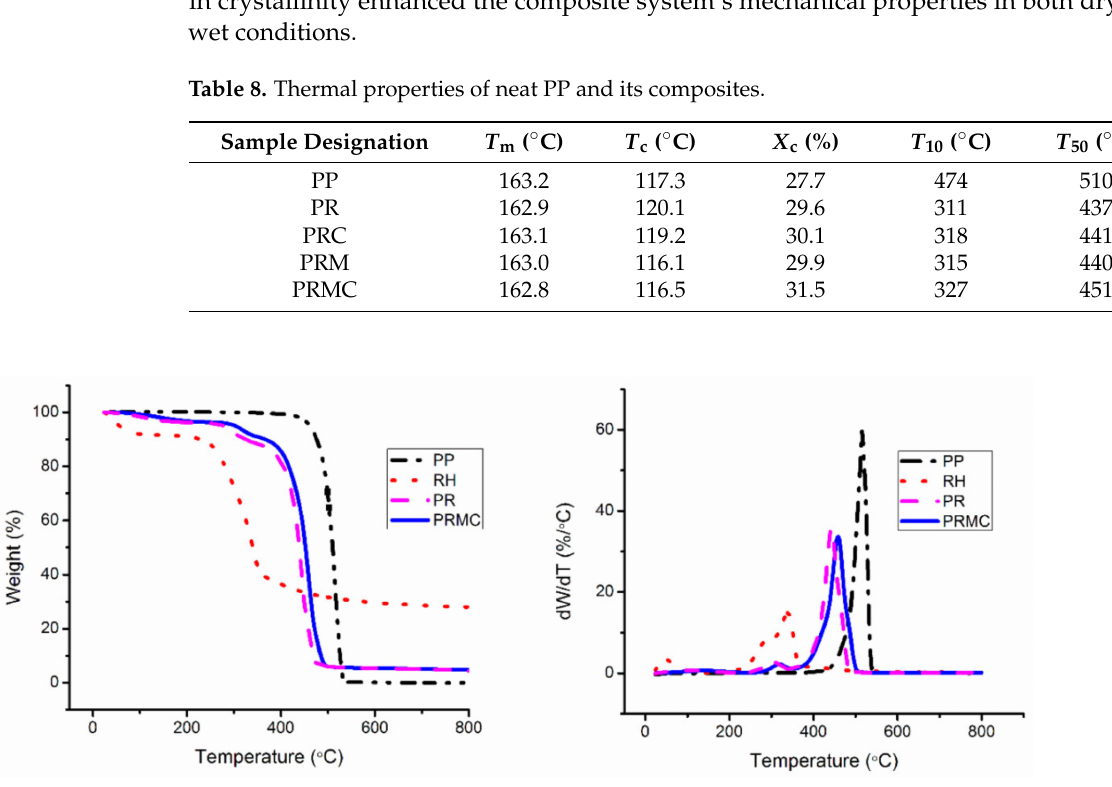
Figure 5. TG/DTG curves for neat PP, RH, and the representative composites. Reproduced from